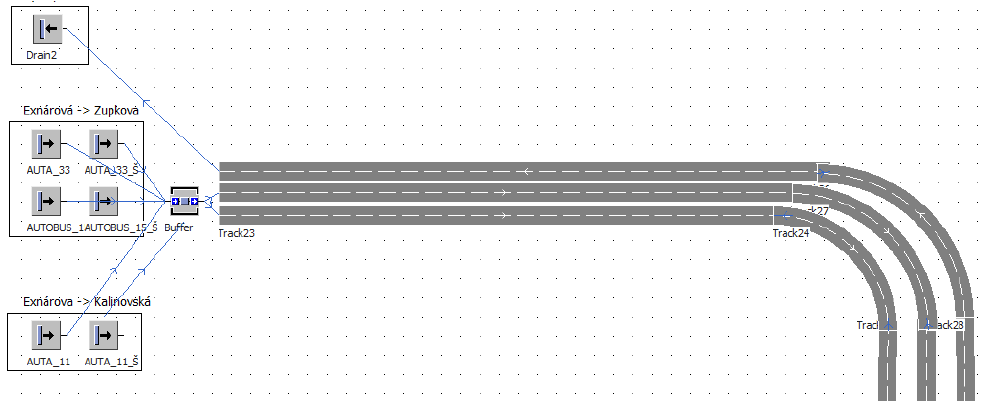
Figure 5. Example of a library in Tecnomatix Plant Simulation.